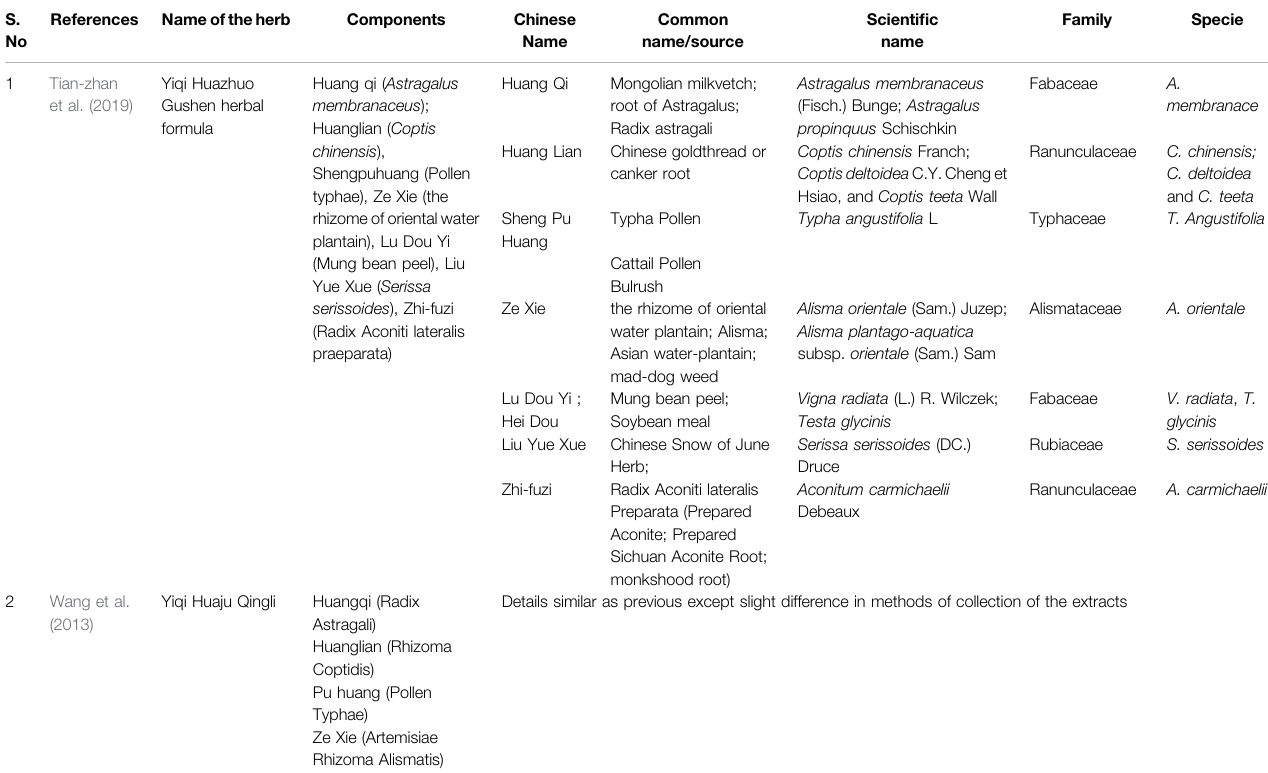
TABLE 2 | Taxonomic classi fi cation of all the polyherbal combinations used in clinical studies against metabolic